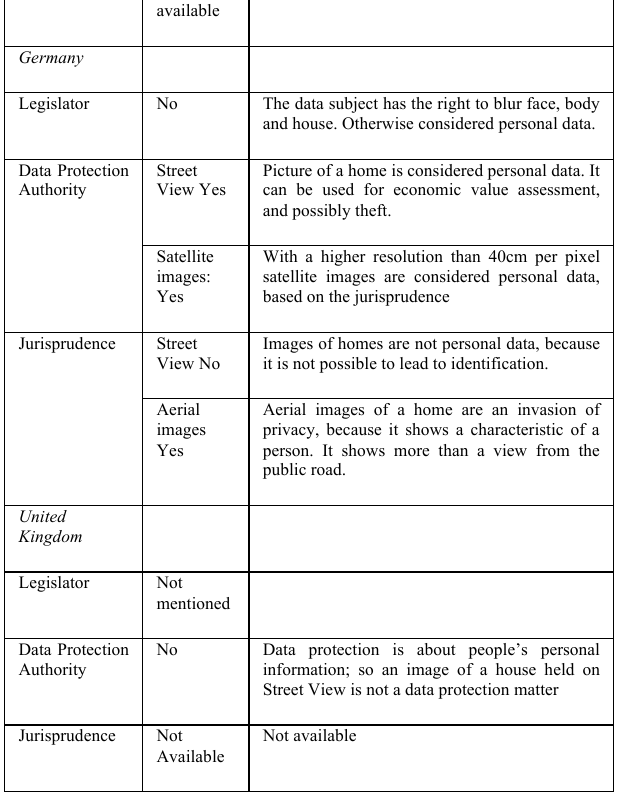
Table 2 Overview of the perspectives on mobile mapping data in EU Member